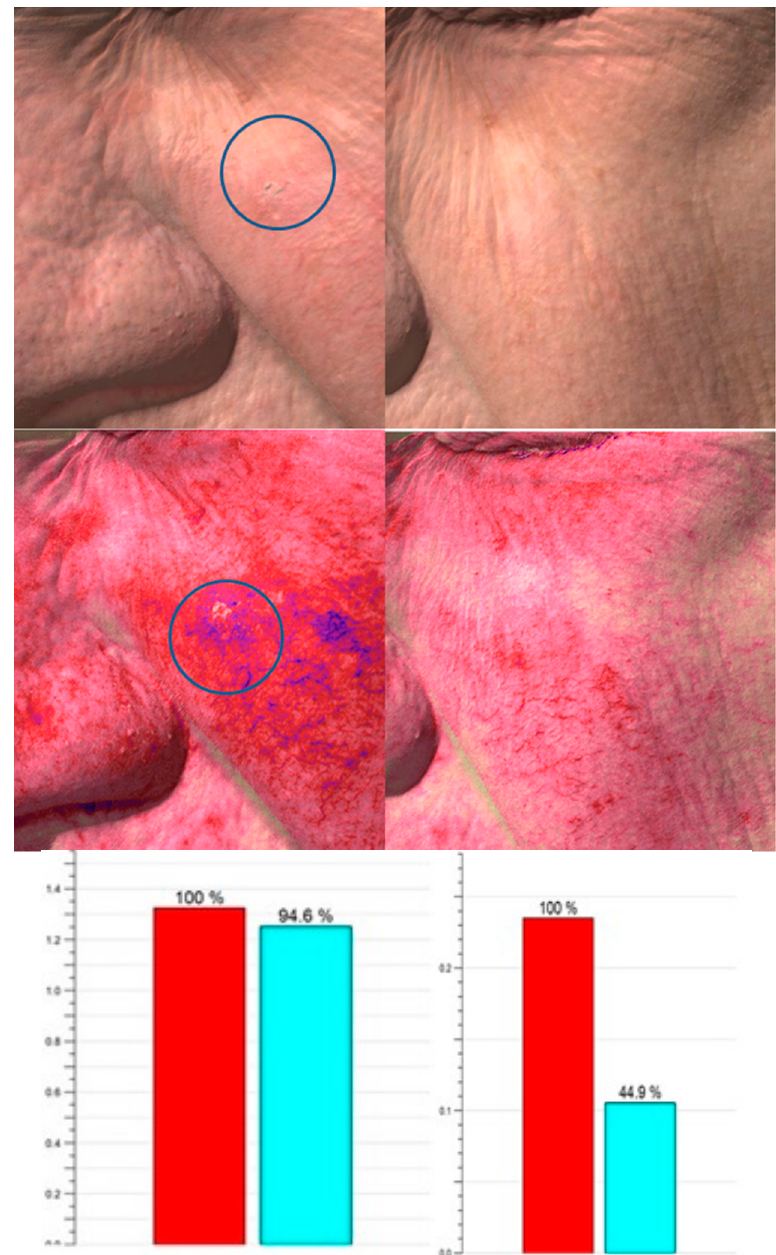
Figure 3. Antera three-dimensional aspect and hemoglobin variation of KINI AK upon examination and after one treatment and automated evaluation. The graphs show the variation of hemoglobin before (red column) and after one treatment (blue column).